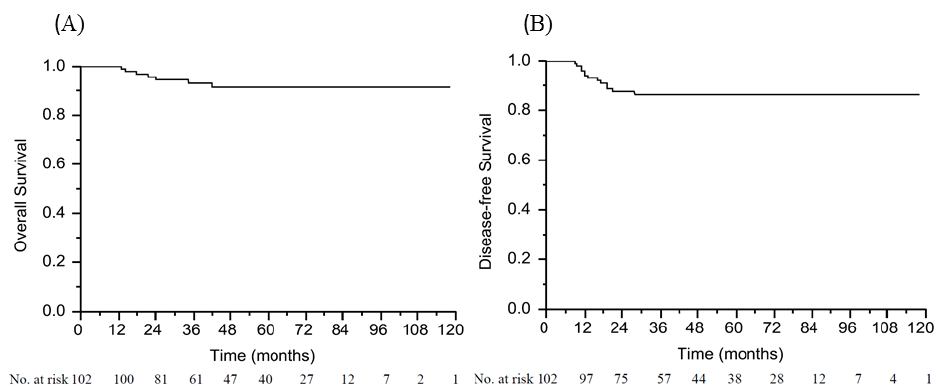
Figure 2. Kaplan–Meier curve depicting overall survival ( A ) and disease-free survival ( B Figure 2. Kaplan – Meier curve depicting overall survival ( A ) and disease-free survival ( B ).